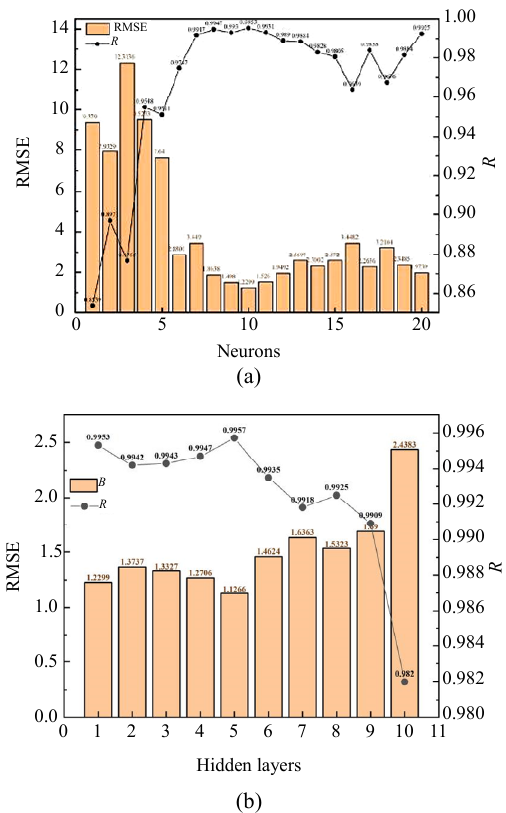
Fig. 10 T -prediction performances of the BPNNs with different models. The data used to evaluate the performance are the ones from the HMF sensor in Fig. 5 in the main